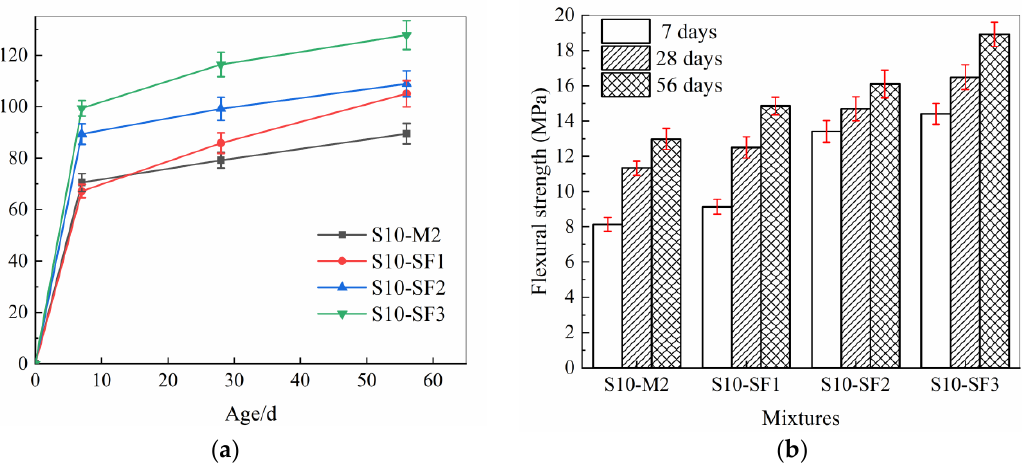
Figure 8. Effects of steel fiber content on compressive strength ( a ) and flexural strength ( b ) of AASSC.